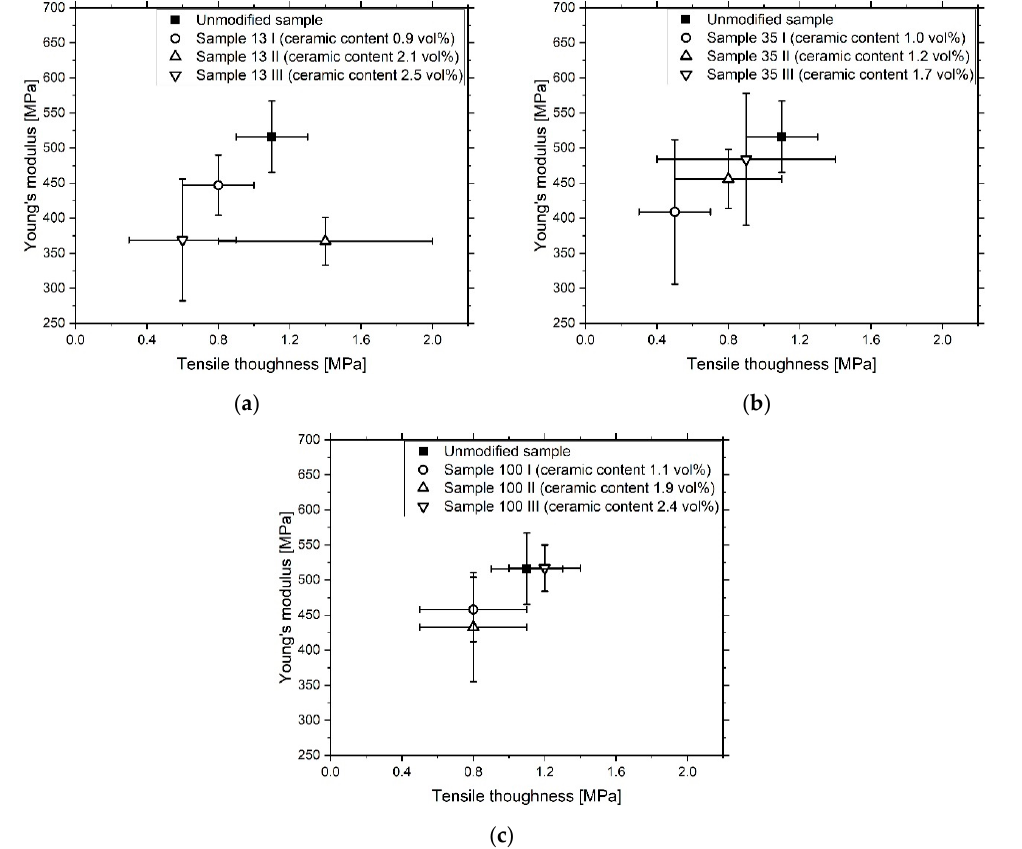
Figure 8. Stiffness/tensile toughness relationship of the printed 13 nm ( a ), 35 nm ( b ) and 100 nm ( c ) filled samples with varying ceramic content.